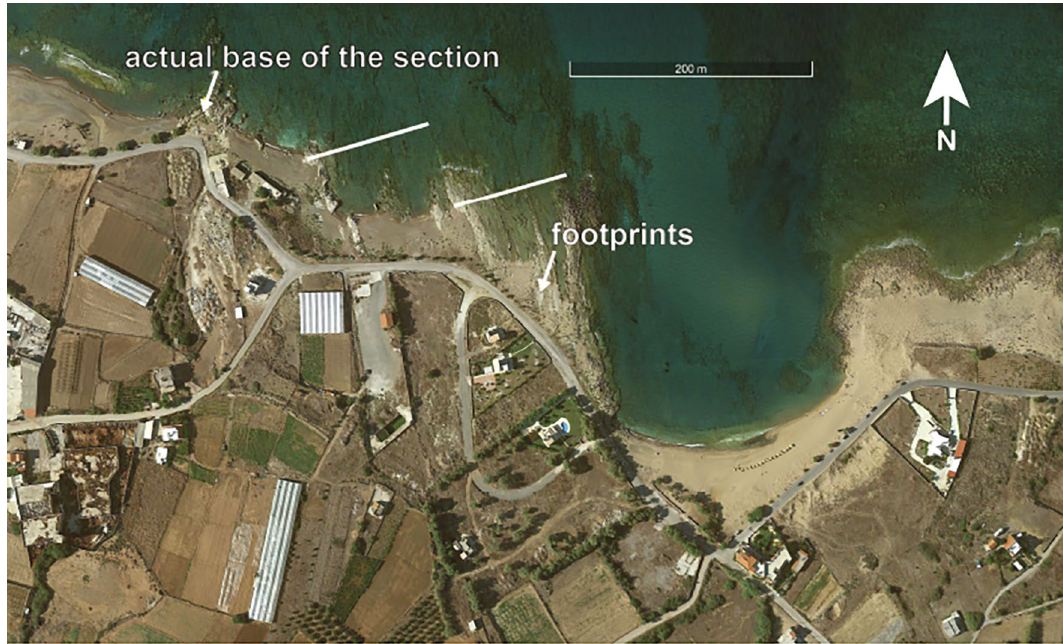
Figure 4. Google Earth satellite image of the Trachilos site (imagery date 9–1-2018). White lines mark the section as published in Gierlinski et al. 1 and Kirscher et al. 2